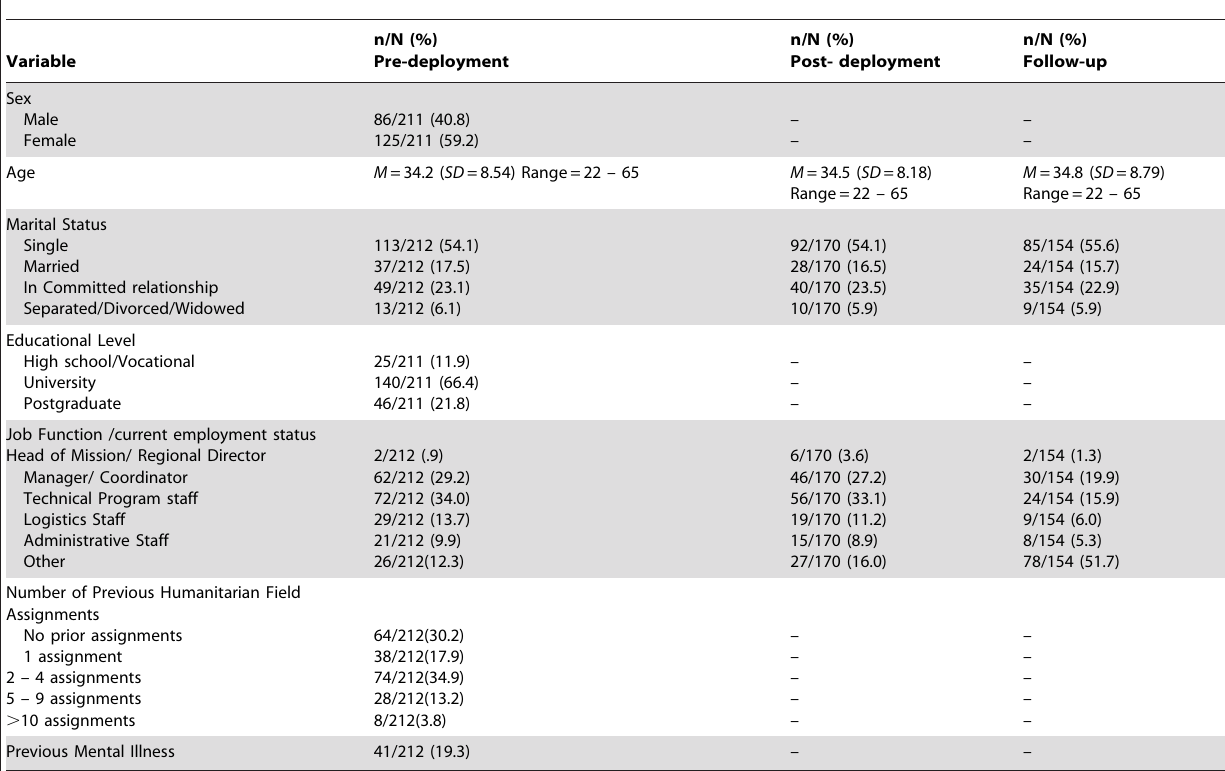
Table 1. Demographic Characteristics of the Humanitarian Aid Worker